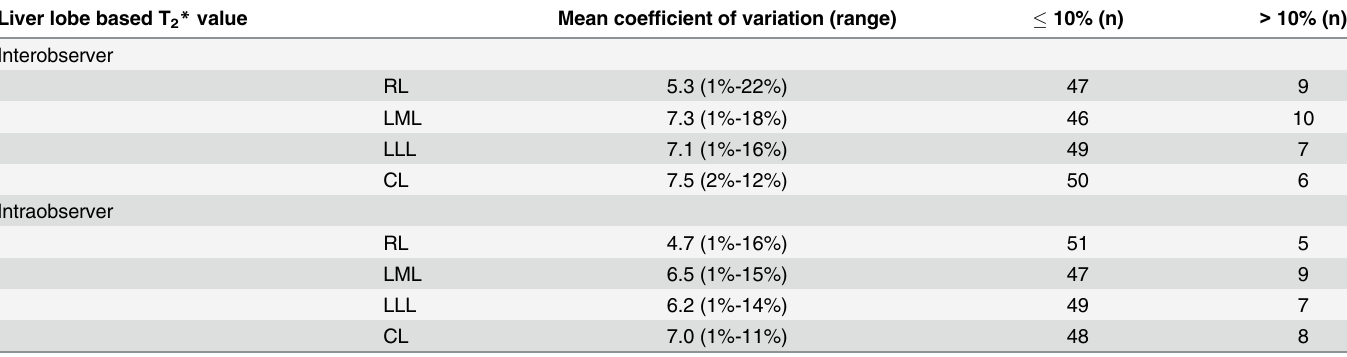
RL = Right liver lobe, LML = Left medial liver, LLL = Left lateral liver lobe, and CL = Caudate